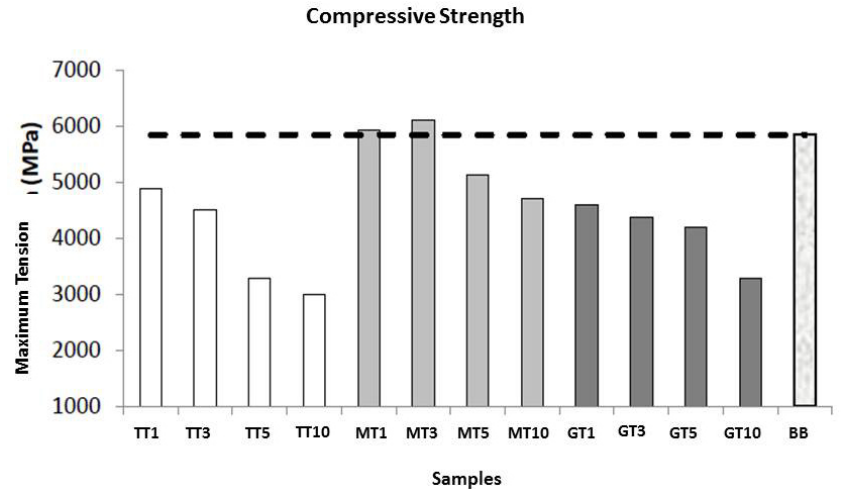
Figure 7. Maximum tension values of each